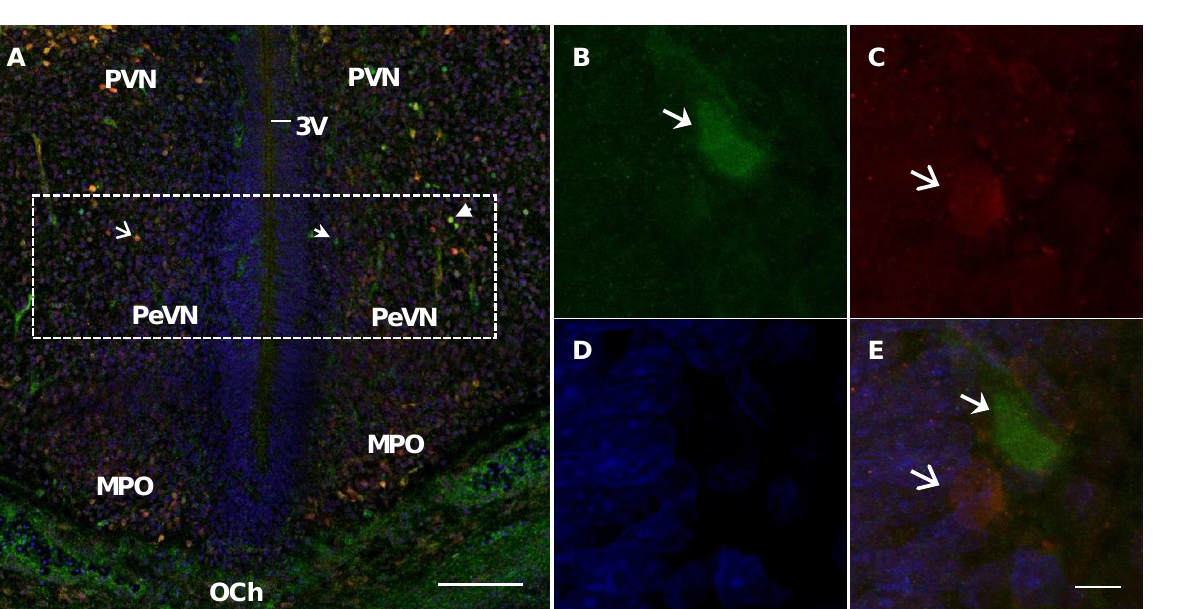
Figure 2. Dopamine content (DA): (i) in vibratome sections of the periventricular nucleus ( A ) or substantia nigra ( B ) of rats on postnatal day 5; (ii) in the medium after incubation of vibratome sections Krebs-Ringer 2-aminobicyclo[2.2.1]heptane-2-carboxylic acid (BCH); (iii) total in vibratome sections of the